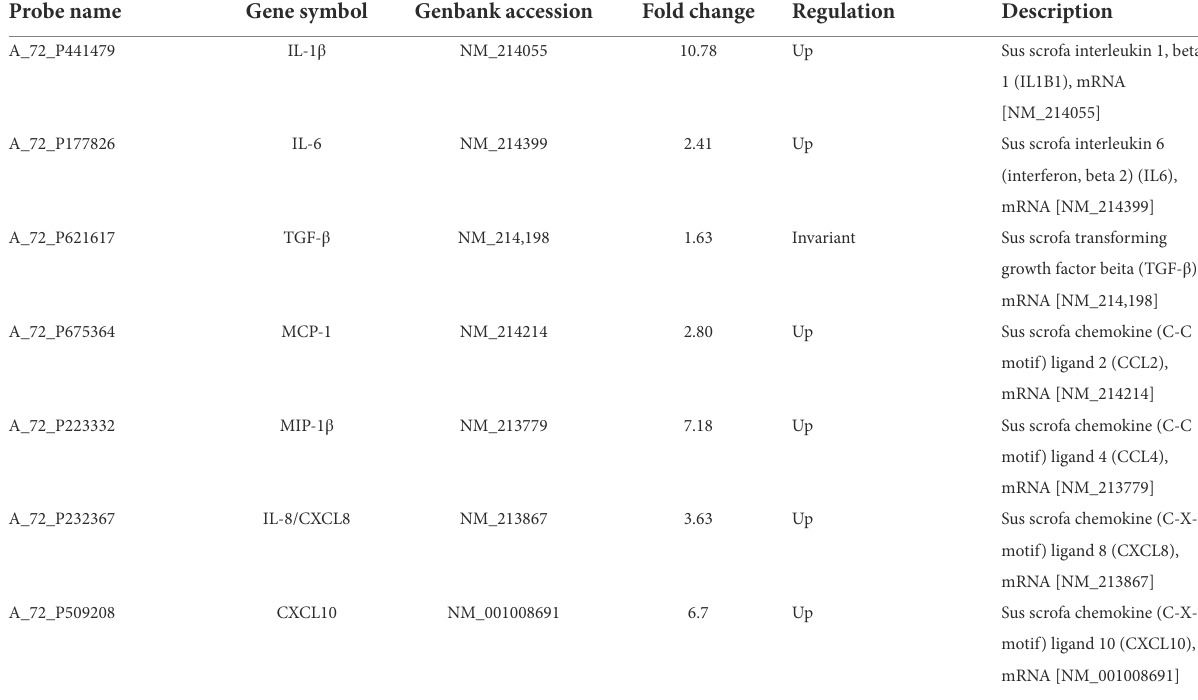
TABLE 2 Differential expressed genes of the partial cytokines in ileum of piglets.